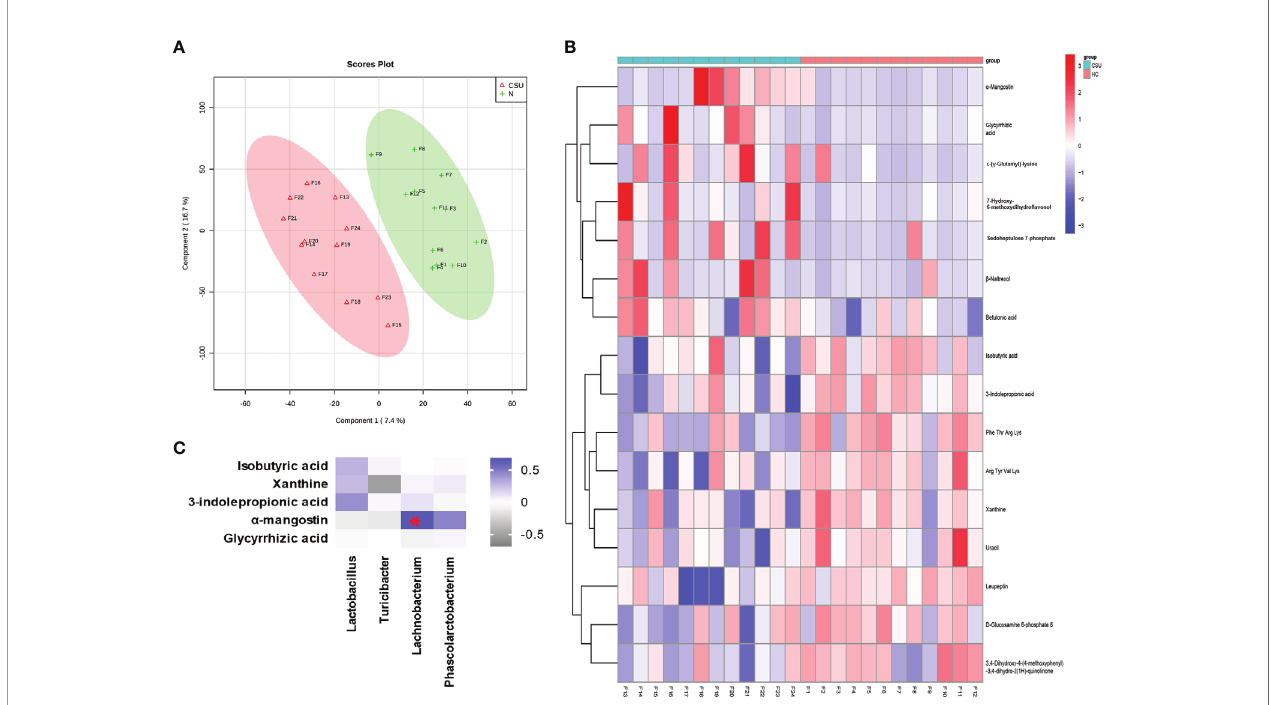
FIGURE 4 | Identi fi cation of the metabolic signatures between patients with chronic spontaneous urticaria (CSU) and healthy controls (HCs). (A) Partial least squares discrimination analysis (PLS-DA) of fecal metabolomic data from CSU patients and HCs. The red and green markers represent CSU patients and HCs, respectively. (B) Fecal metabolic patterns in CSU patients and HCs shown as a heatmap. Rows represent data for metabolites and columns represent the subjects. Red and blue colors represent increased and decreased levels, respectively, of metabolites in patients with CSU compared to those in HCs. (C) Correlation for the signi fi cantly changed fecal metabolites and microbial genera. The square with a red asterisk refers to | r | > 0.60 and p < 0.05. Blue indicates a positive correlation while white indicates a negative